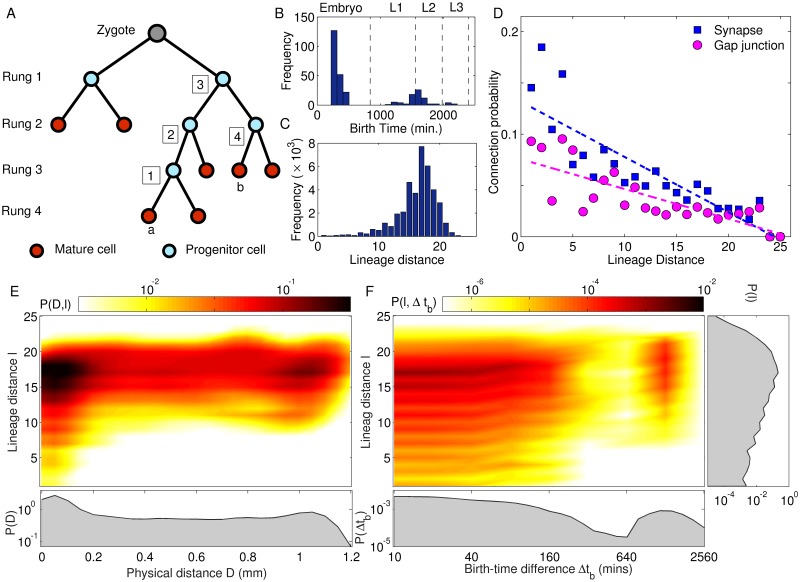
Lineage of neurons affects their synaptic connectivity and spatial localization.(A) Schematic diagram of a lineage tree of cells resulting from consecutive mitotic divisions of the zygote. The terminal nodes of the tree correspond to terminally differentiated mature cells (shown in red) while other nodes represent progenitors (shown in blue) that appear at different rounds of cell division. Cells born at each round of cell division are indicated by the corresponding rung of the tree they belong to, the numerical value for the rung (shown at the left) being the number of divisions starting from the zygote. The lineage distance l between a pair of mature cells is measured as the total number of cell divisions leading to each from their common progenitor. An example of lineage distance measurement is shown in the figure for the pair of cells a and b which are separated by four cell divisions (the distance of a from each of the intermediate dividing progenitors is indicated in the figure). (B-C) Frequency distributions of the birth time of different neurons (B, separated into the different developmental stages) and the lineage distances for each pair of neurons (C). (D) The probability of a pair of neurons to be connected through a synapse decreases with increasing lineage distance between them, as indicated by a statistically significant linear correlation between the two (r = −0.87, p < 10−7). For gap junctional connections, the correlation is marginally weaker (r = −0.79, p < 10−5). (E-F) Joint probability distributions of lineage distance l along with distance between cell bodies D (E) and birth time difference Δtb (F) between all pairs of neurons. The marginal distributions for the corresponding quantities are also shown. We notice that the distribution of physical distances in (E) exhibit a bimodal nature. However, cells which are closely related in terms of lineage (l < 5) also has a high probability of being physically located nearby (indicated by a prominent peak at the lower end of the distribution of D) which suggests that lineage influences spatial localization of cells. In panel (F), the distribution shows peaks at odd values of the lineage distance (particularly for low Δtb) suggesting that neurons born close in time are located at the same rung on the lineage tree.